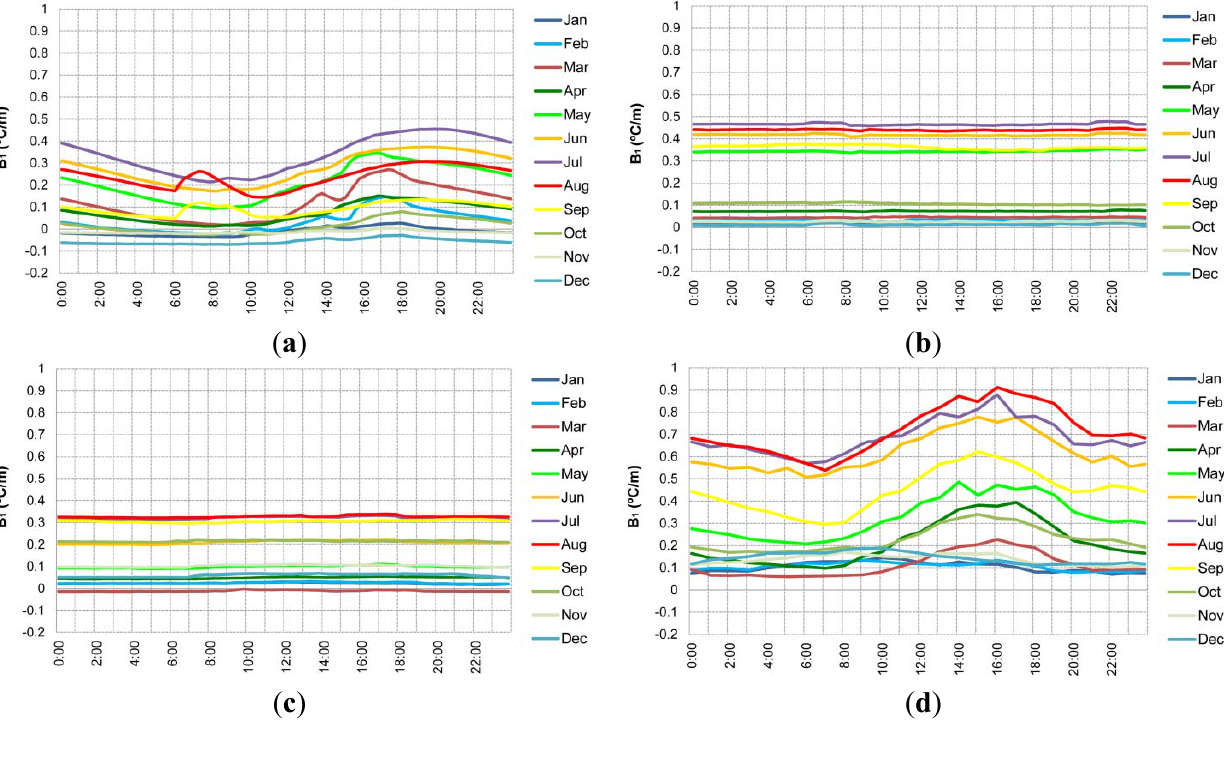
Figure 5. Daily evolution of the stratification of indoor air, measured through the coefficients β . Monthly average values: ( a ) aboveground without air-conditioning; ( b ) 1 basement; ( c ) earth-sheltered; and ( d )